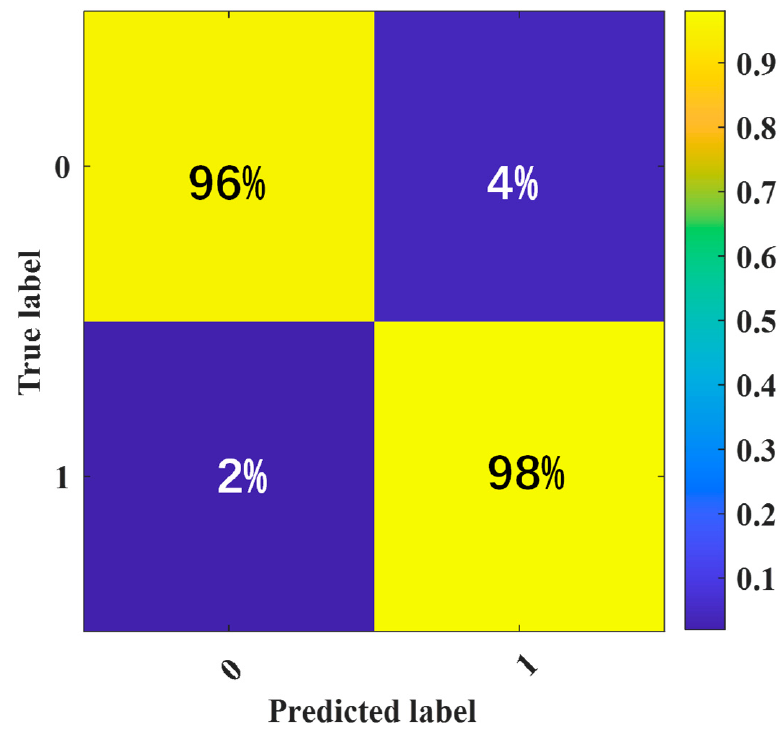
Figure 10. Confusion matrix of SVM model.